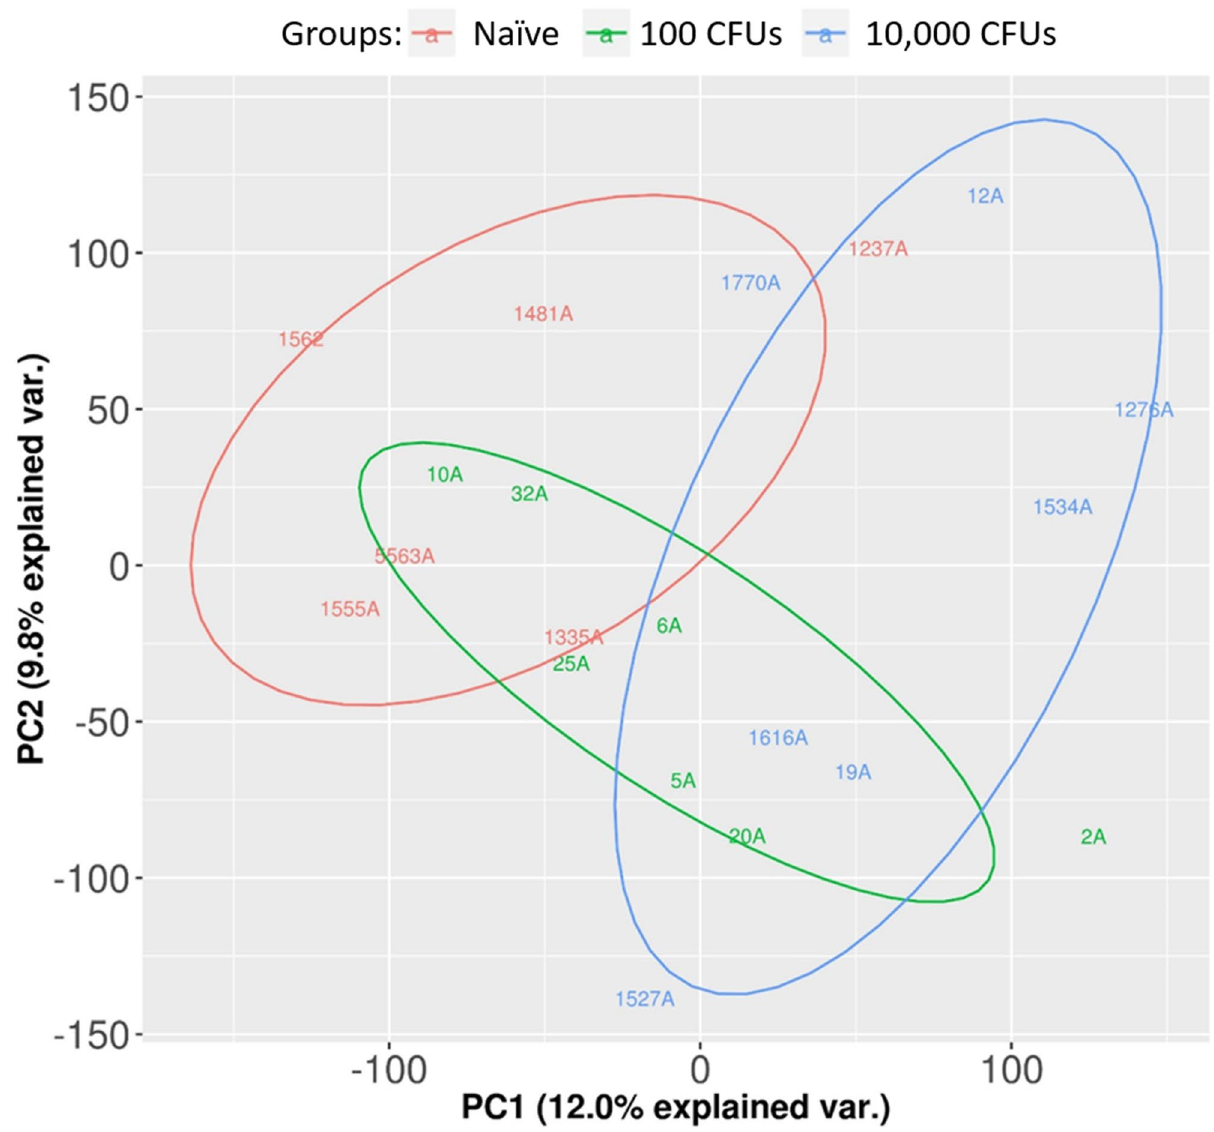
Figure 5. Principal Component Analysis of differentially expressed genes in the three experimental groups. Naïve control animals in red, 300 CFU inoculation group in green, and 30,000 CFU inoculation group in blue. Identifiers represent animal